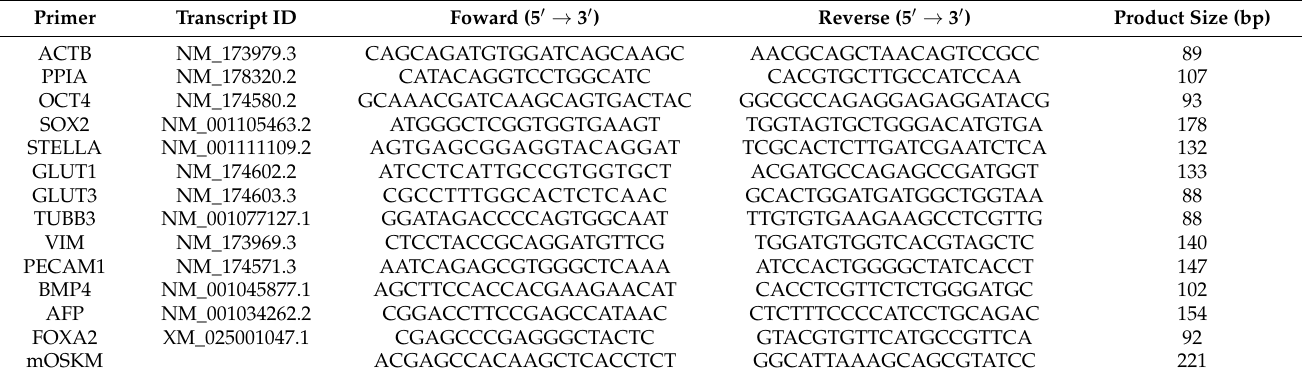
Table 1. List of primer sequences, transcript IDs and product sizes used to characterize pluripotency, metabolism and differentiation.